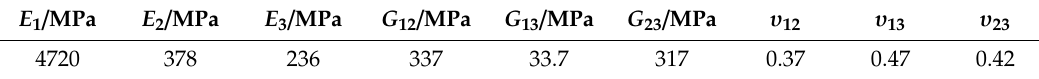
Table 1. Elastic material parameters of the finite element (FE) mode.